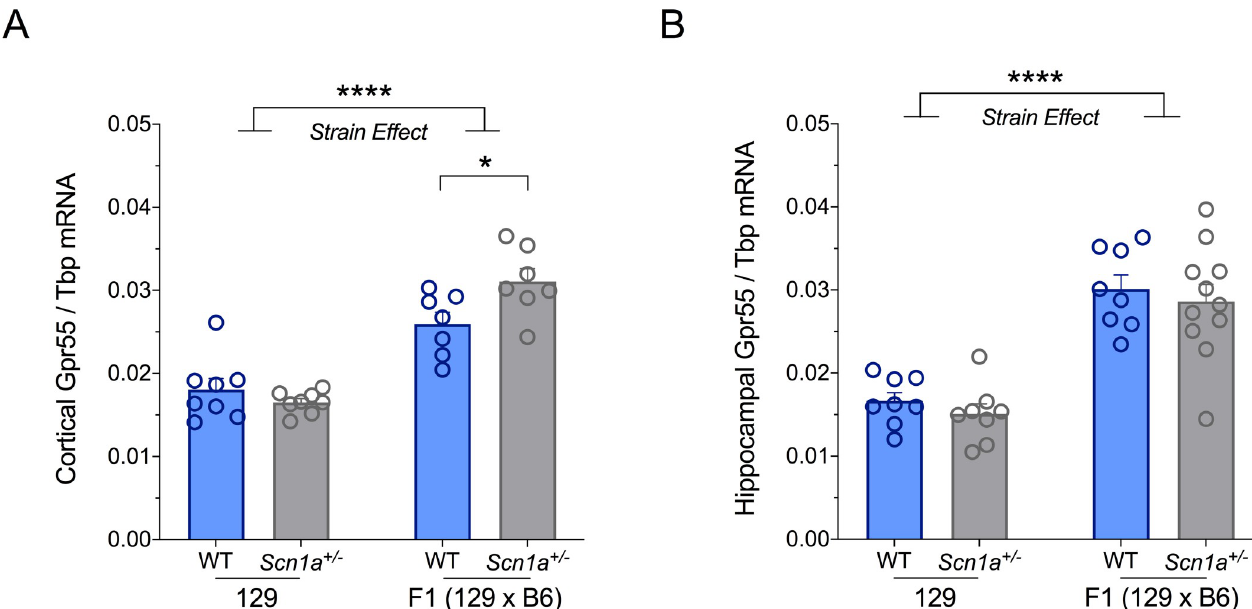
Fig 1. Strain-specific Gpr55 expression. Relative Gpr55 transcript levels in the ( A ) cortex and ( B ) hippocampus of wildtype (WT, blue bars) and Scn1a +/- (gray bars) mice on 129 and F1 (129 x B6) background strains. Gpr55 expression was measured in primary RNA pools using RT-ddPCR and are expressed as a ratio of Tbp . Each primary pool includes tissue from 3–4 mice, with at least one from each sex. Data represents mean ± SEM, with n = 7–11 pools per group. Cortical and hippocampal samples were dissected and pooled from different cohorts of F1. Scn1a +/- mice. Cortical and hippocampal Gpr55 expression was significantly greater in F1 compared to 129 mice ( ���� p < 0.0001, two-way ANOVA). Scn1a +/- mice expressed significantly greater Gpr55 than wildtype mice on the F1 (129 x B6) background strain ( � p < 0.05 two-way ANOVA followed by Sidak’s test).